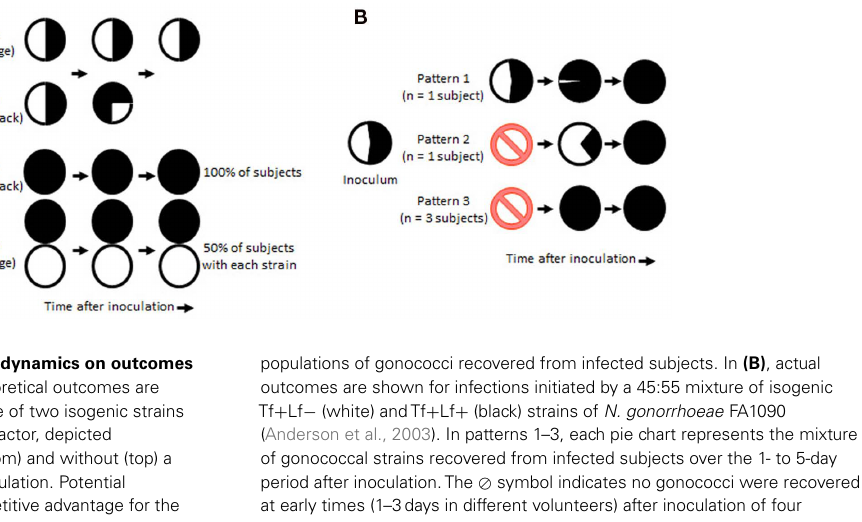
FIGURE 3 | Potential influence of population dynamics on outcomes of mixed experimental infections. In (A) , theoretical outcomes are shown for infections initiated by a 50:50 mixture of two isogenic strains differing in expression of a predicted virulence factor, depicted as black and white, under conditions with (bottom) and without (top) a population-restricting bottleneck early after inoculation. Potential outcomes consistent with and without a competitive advantage for the black strain are indicated as four patterns of pie charts representing